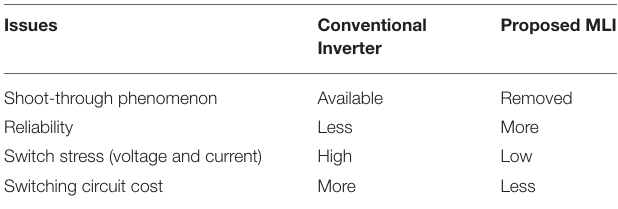
TABLE 1 | Comparative analysis between Conventional Inverter and proposed